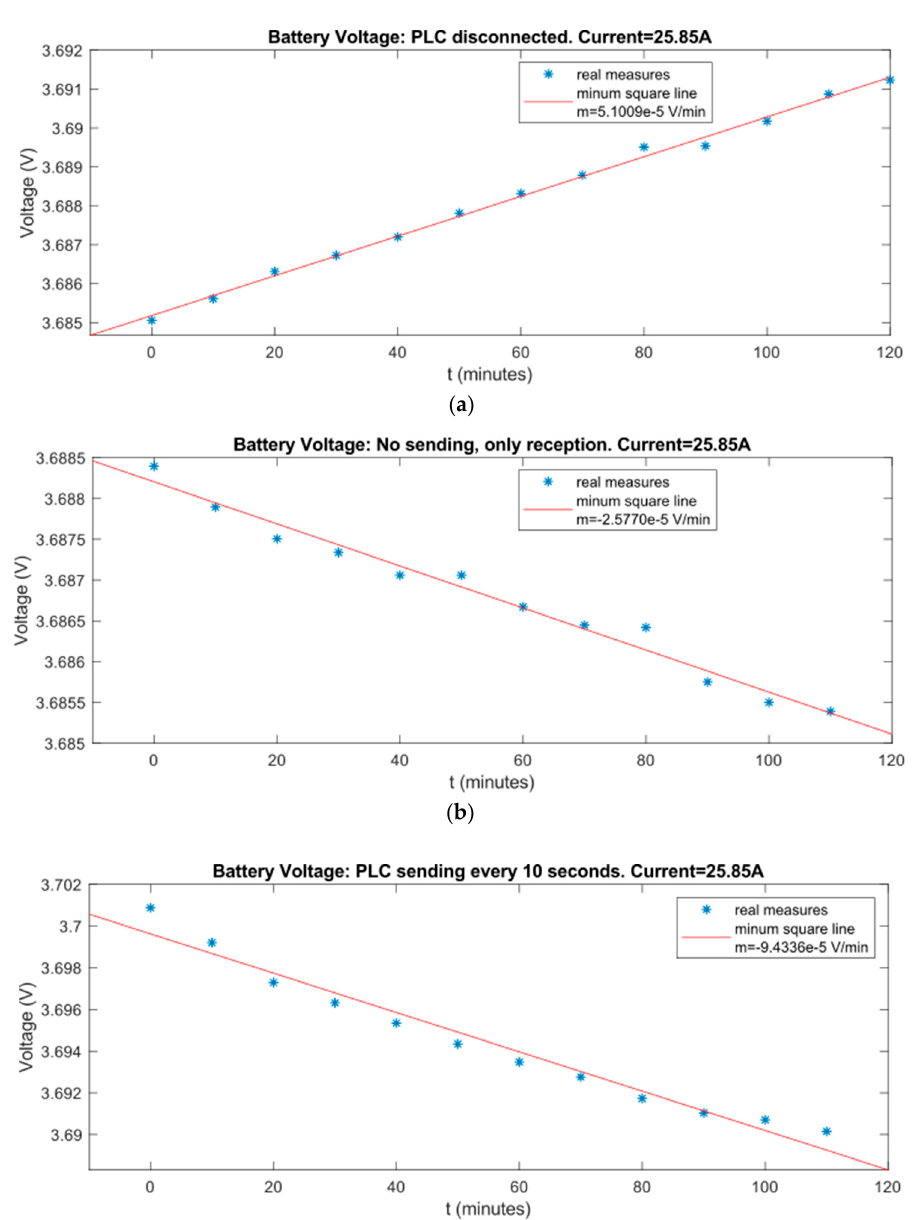
Figure 21. ( a ) Battery voltage: PLC disconnected; ( b ) Battery voltage: only reception; and ( c ) Battery voltage: sending and receiving.